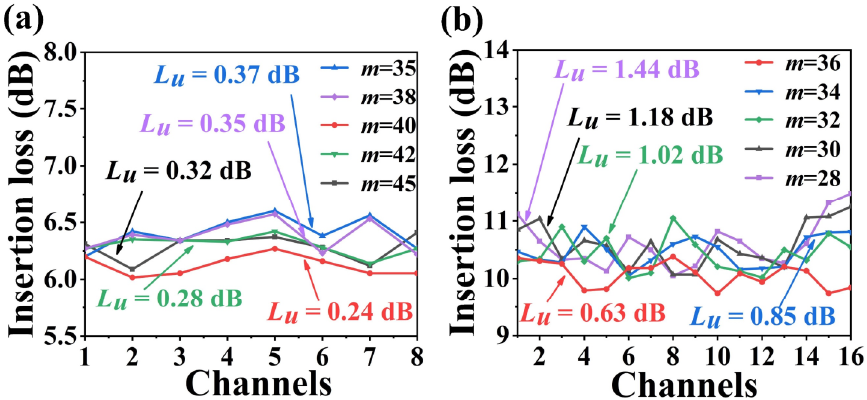
Figure 4. Simulated non-uniformity and insertion loss for all output channels of ( a ) 8 and ( b ) 16- channel nanowire-assisted AWG with the variation of the diffraction order m .